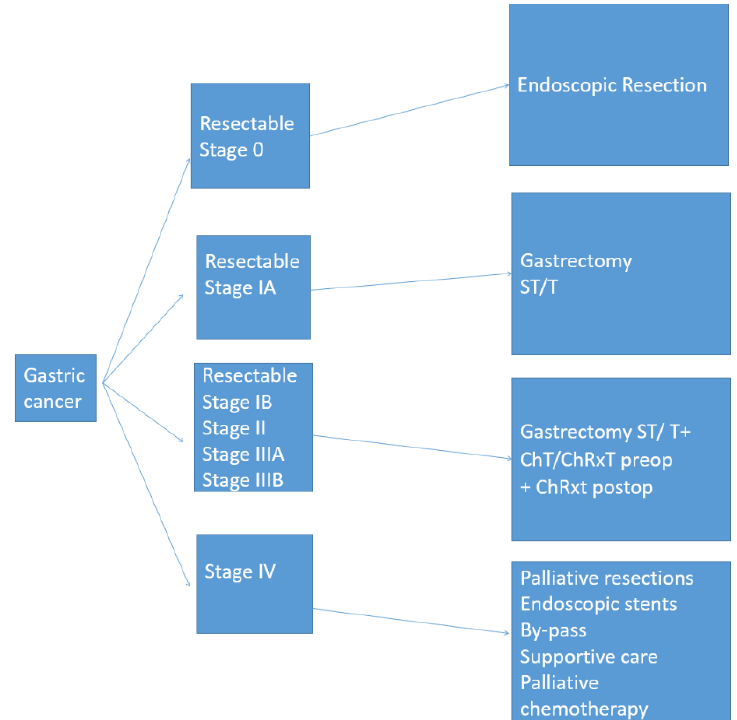
Figure 1. Treatment strategies of gastric cancer according to TNM stage. Stage 0: TisN0M0; stage